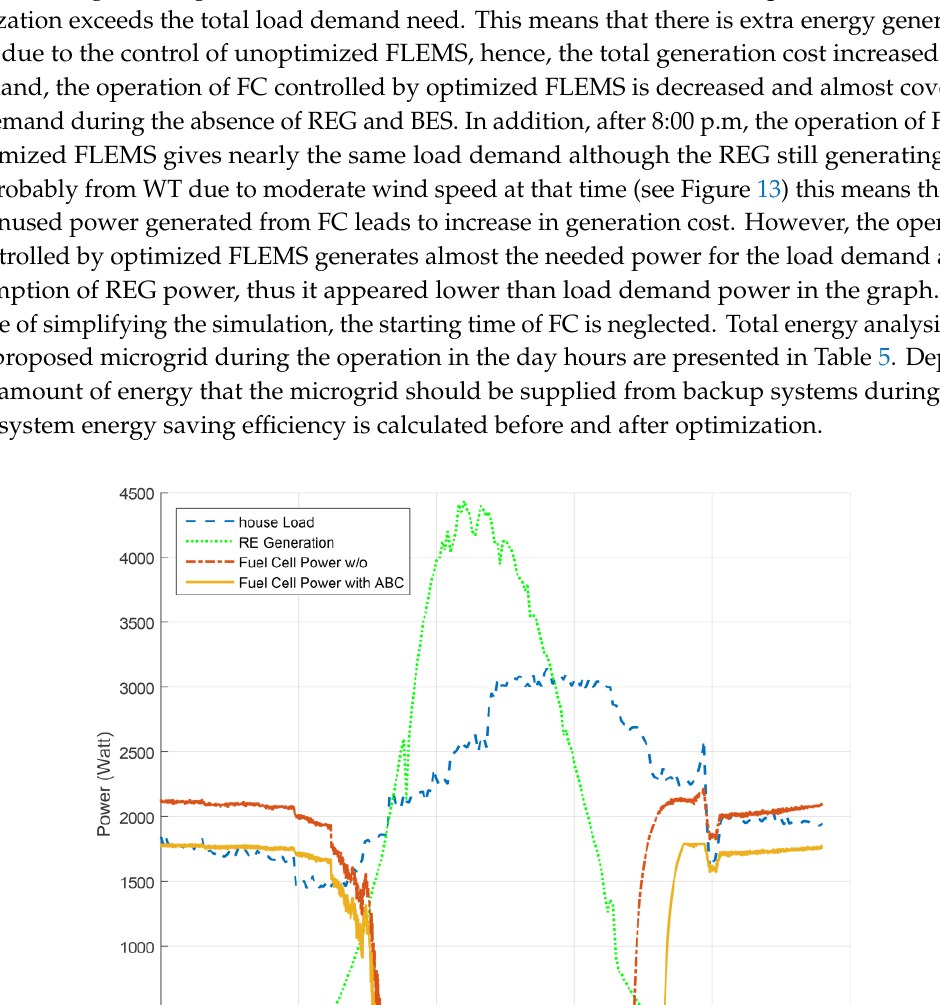
Figure 17. Operation of FC with/without optimization compared with REG and load demand for 24 of a typical summer day (28th July